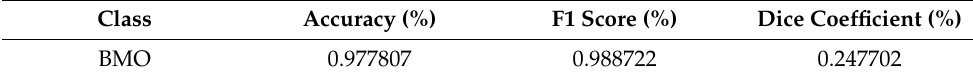
Table 3. BMO class processing results from the segmentation